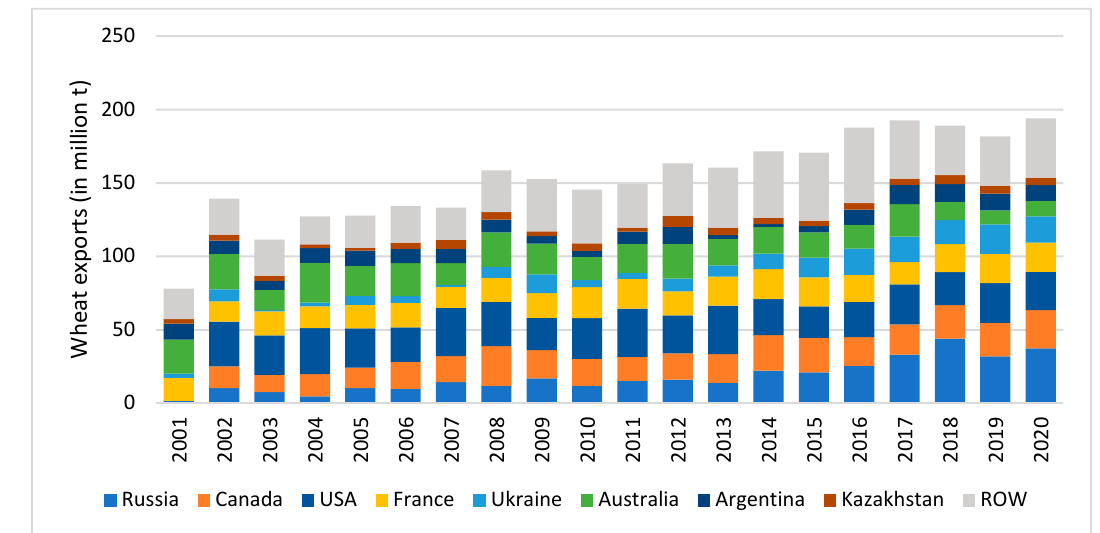
Figure 2. Selected leading world wheat exporting countries (2001–2020). Abbreviation: ROW, rest of the world. Data source: [24]. Own illustration.